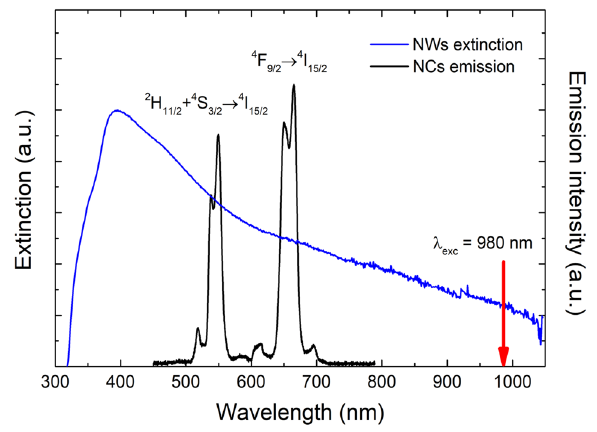
Figure 1. Extinction spectrum of a colloid of silver nanowires (blue line) together with the emission spectrum of a single nanocrystal (black line). The excitation of 980 nm laser diode was used, as indicated by the red